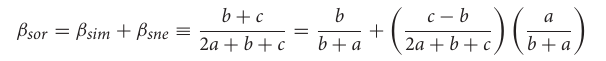
Frontiers in Environmental Science |